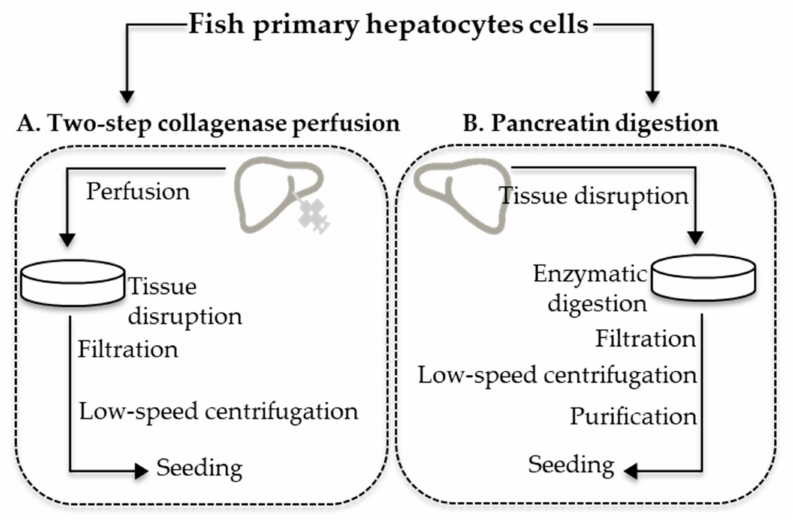
Figure 1. Primary fish hepatocytes isolation methods applied: ( A ) two-step collagenase perfusion and ( B ) pancreatin